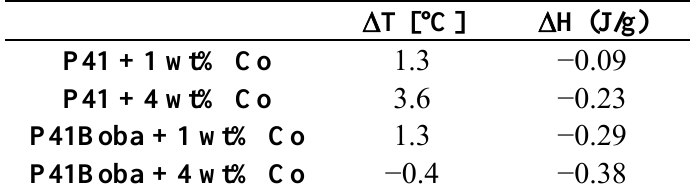
Table 2. Isotropic to nematic transition temperature (  T) and enthalpic (  H) changes